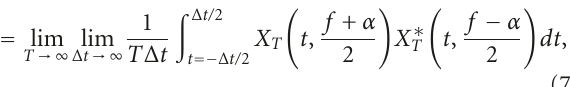
Figure 1: Baseband signal frequency spectrum (top) and SCD at the symbol rate (bottom). The frequency spectrum results from the repetitive discrete signal spectrum and the filter shaping. The SCD is measured by the correlation between two frequency bins centered on f − α/ 2 and f + α/ 2 where α is the symbol rate. The symbol rate feature exists for baseband PAM/QAM signals if there is some excess bandwidth in the